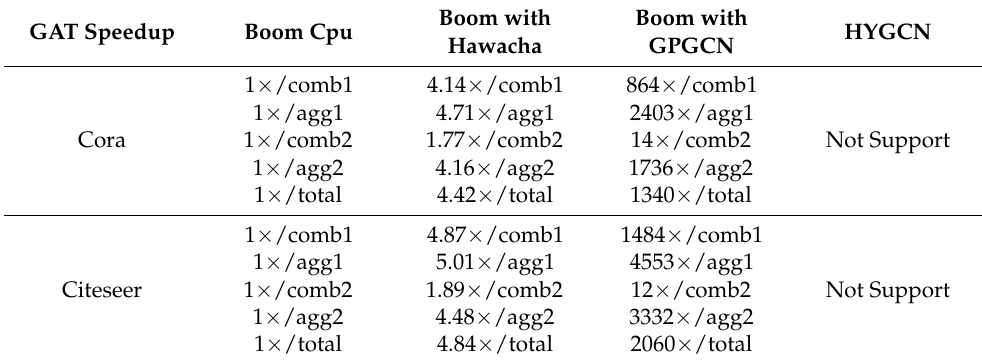
Table 11. The GAT execution speedup of different hardware with different